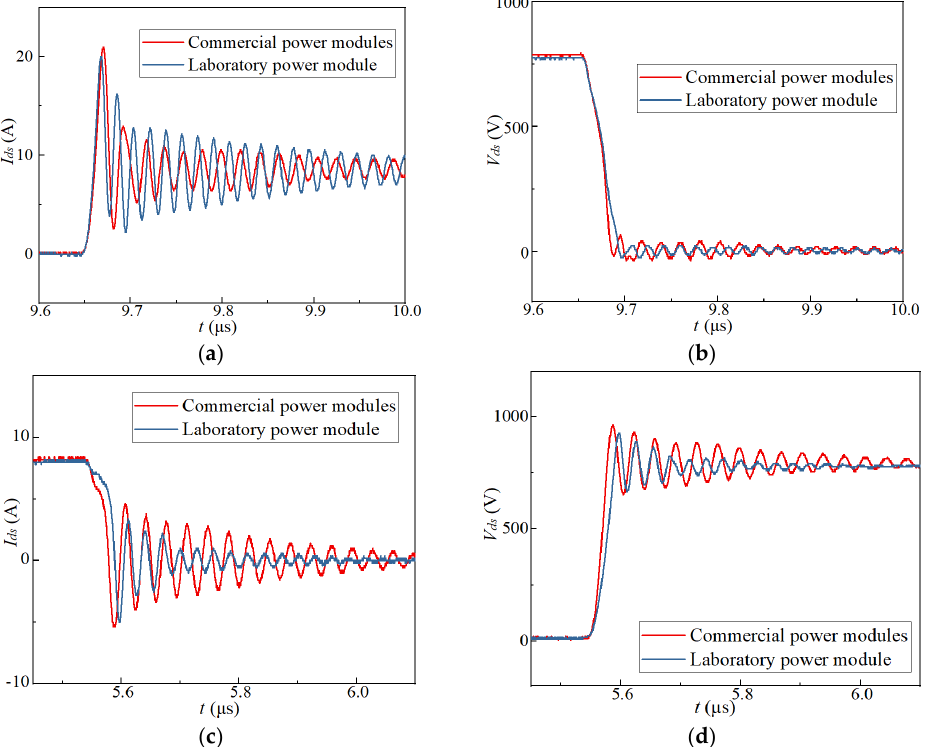
Figure 14. Double pulse test results: ( a ) drain–source current during turn-on; ( b ) drain–source voltage during turn-on; ( c ) drain–source current during turn-off; ( d ) drain–source voltage during turn-off.